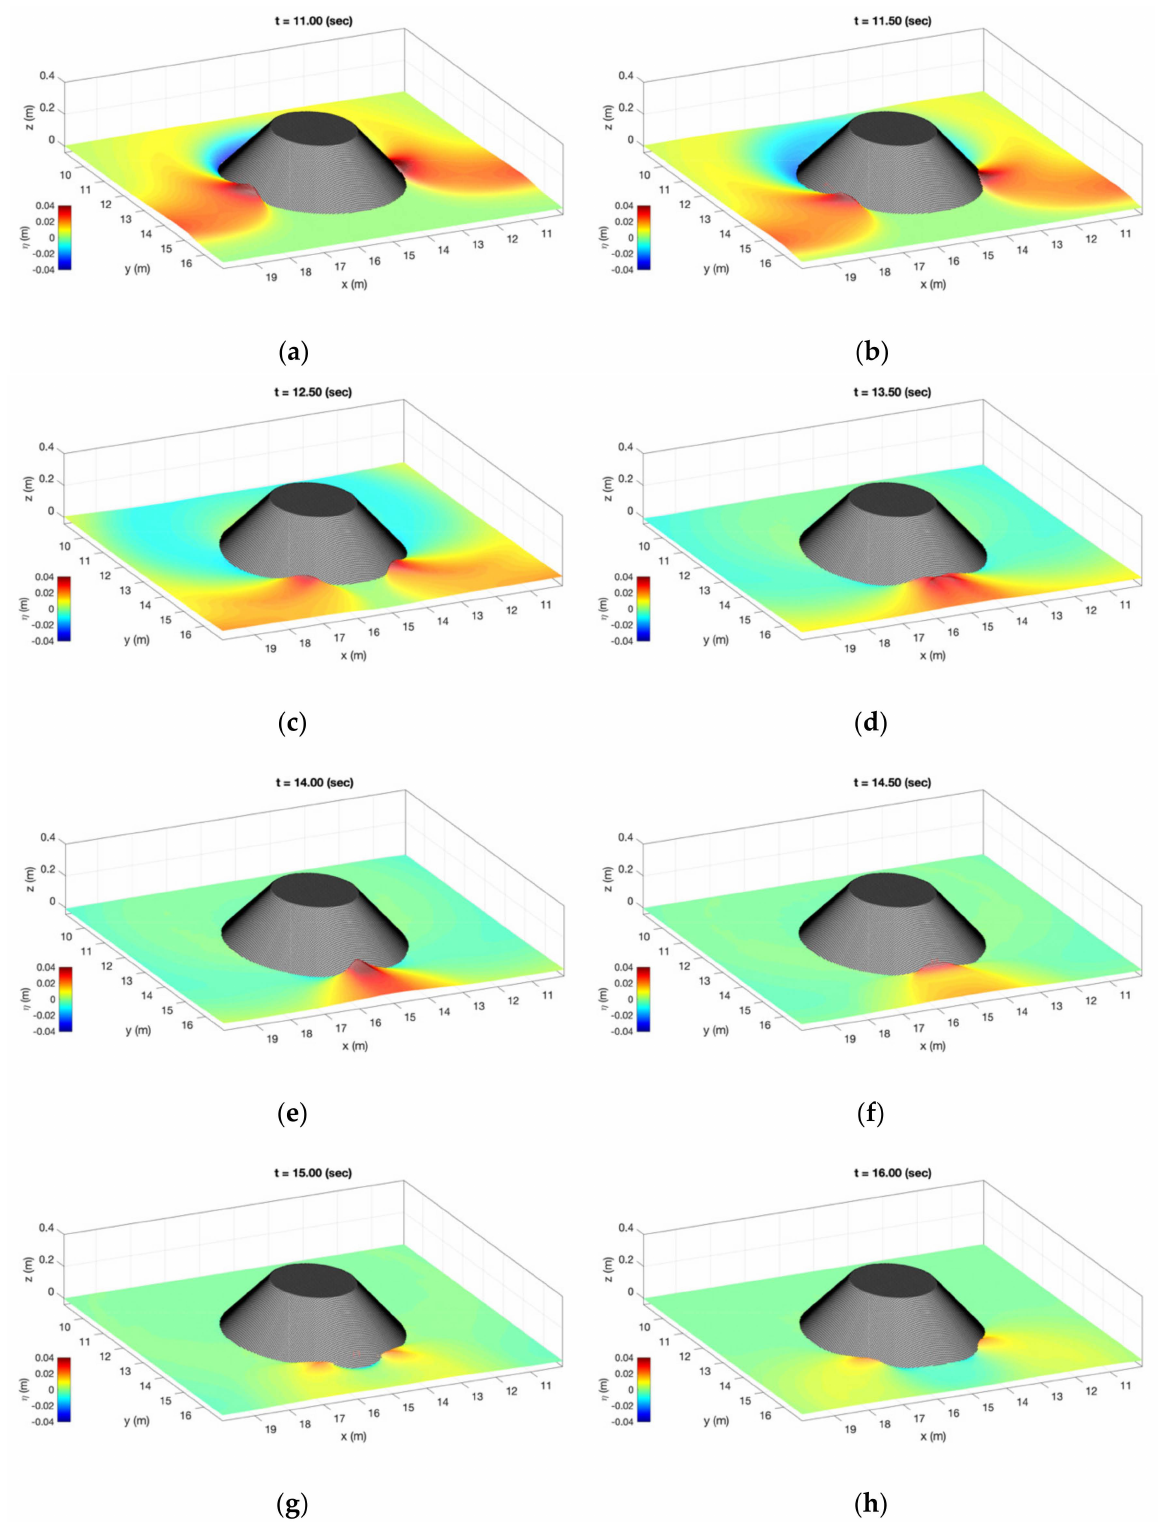
Figure 6. Snapshots for the computed free surface elevations of Grid 02 on the lee side of the circular island (A/h = 0.091) at t = ( a ) 11.0, ( b ) 11.5, ( c ) 12.5, ( d ) 13.5, ( e ) 14.0, ( f ) 14.5, ( g ) 15.0, and ( h ) 16.0 sec. The incident solitary wave propagates along the + y -direction. The color bar indicates the free surface elevations in the unit of m. The gray-shaded object shows the circular